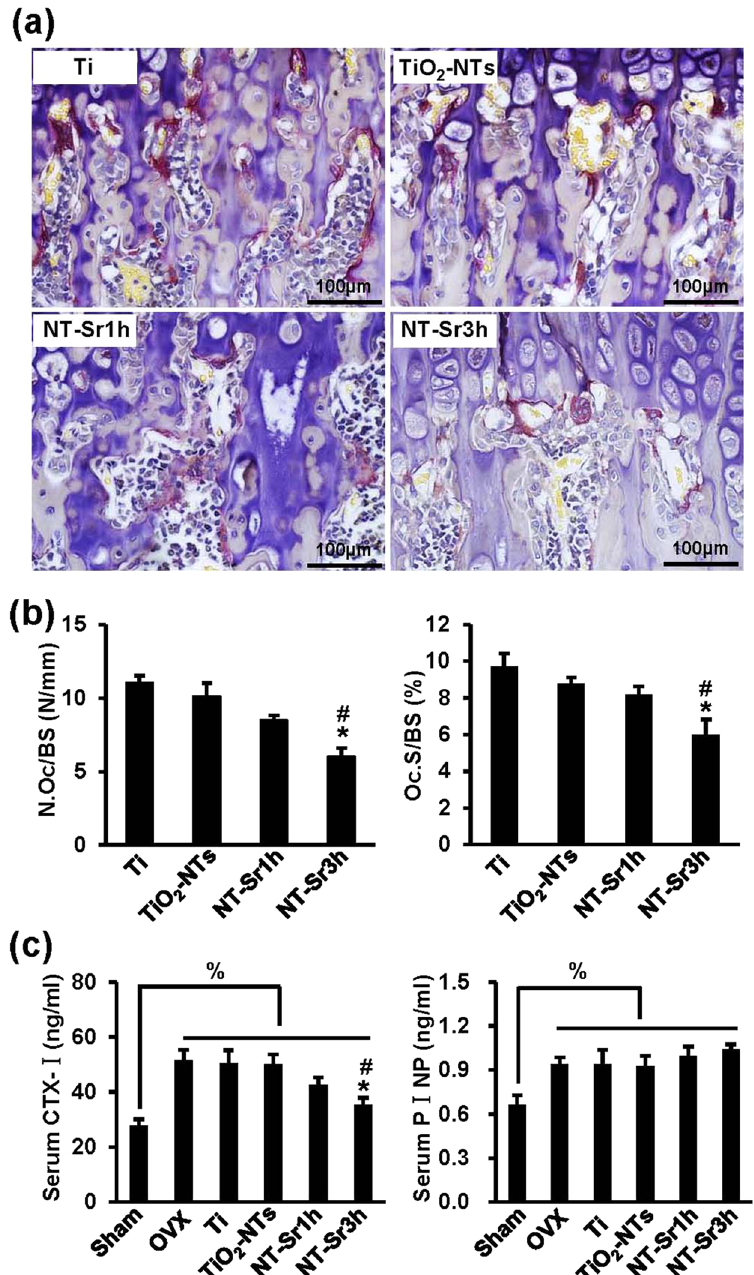
Figure 9. NT-Sr decrease osteoclast formation and function in vivo . ( a , b ) OVX rats were sacrificed eight weeks after implantation, sections of the metaphyseal regions of the proximal tibias (the area above the proximal end of the implant) were selected for TRAP staining, and osteoclastic parameters such as N.Oc/BS and Oc.S/BS were measured. The red multinucleated cells were considered osteoclasts. The scale bar represents 100 μ m ( a ). Low- magnification images are presented in Supplementary Figure 5. ( c ) The serum levels of CTX-I and PINP were examined by ELISA. * p < 0.05 compared with the Ti group, # p < 0.05 compared with TiO 2 -NTs, and % p < 0.05. The data are presented as the means ± SDs with n = 12 per